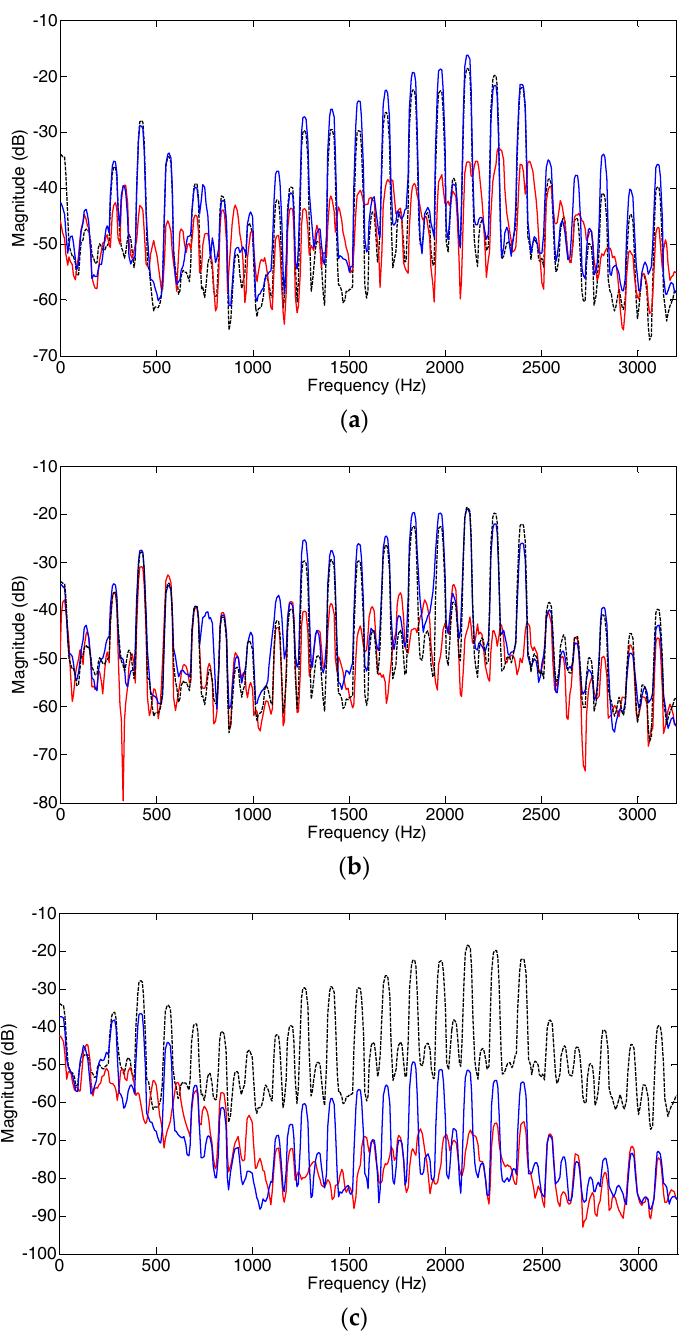
Figure 7. Spectra of noise measured at the KEMAR’s ear without earphone on it (black), with earphone but without ANC (blue), and after ANC is turned on (red). ( a ) Clip earphone; ( b ) earbud earphone; ( c ) in ‐ ear earphone.